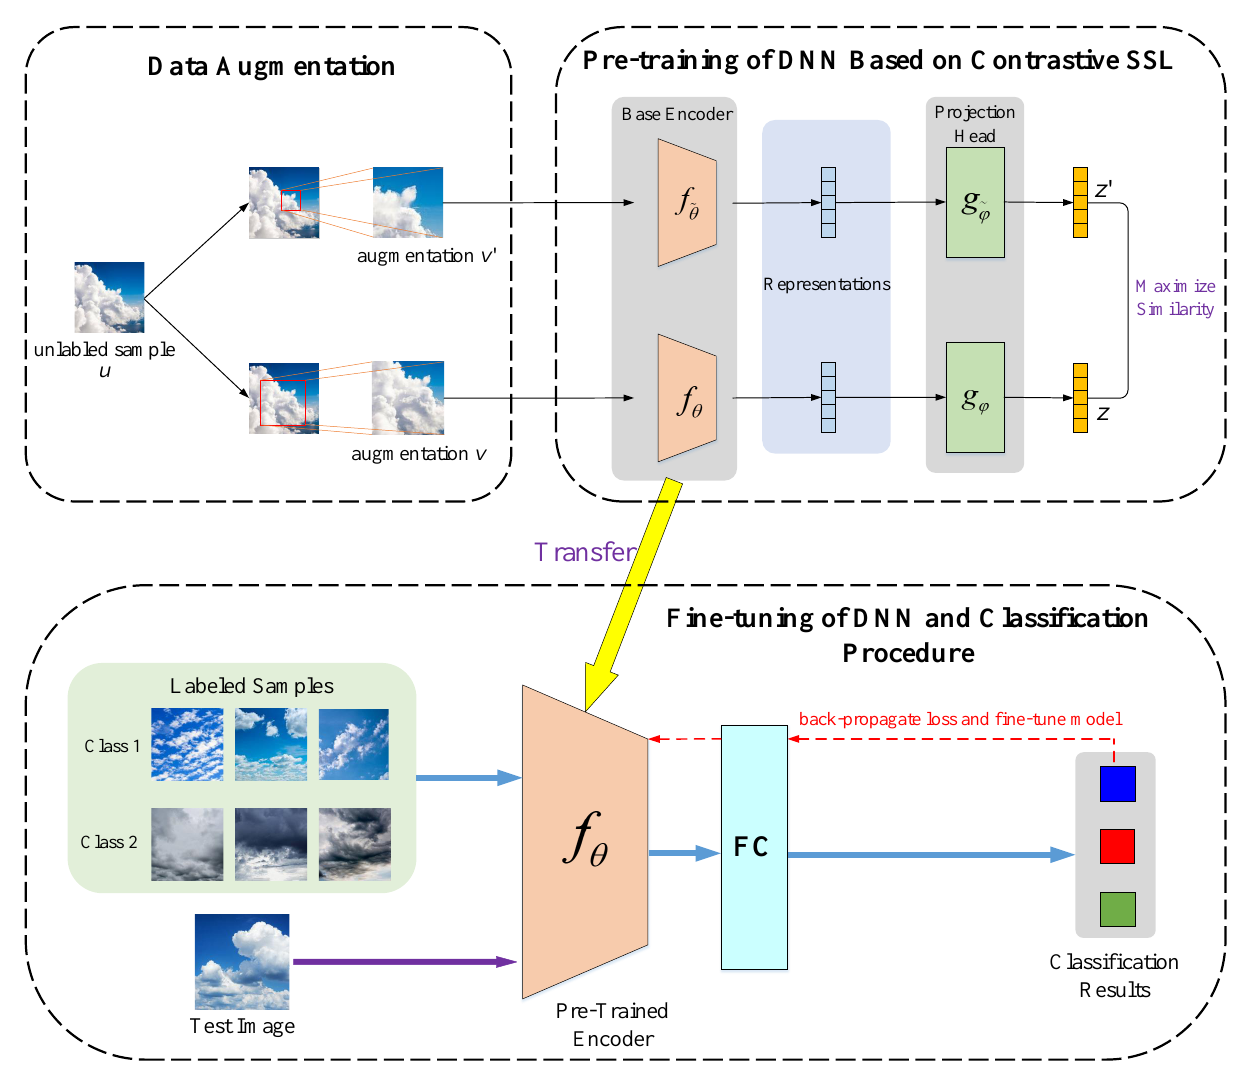
Figure 2. Schematic diagram of the proposed